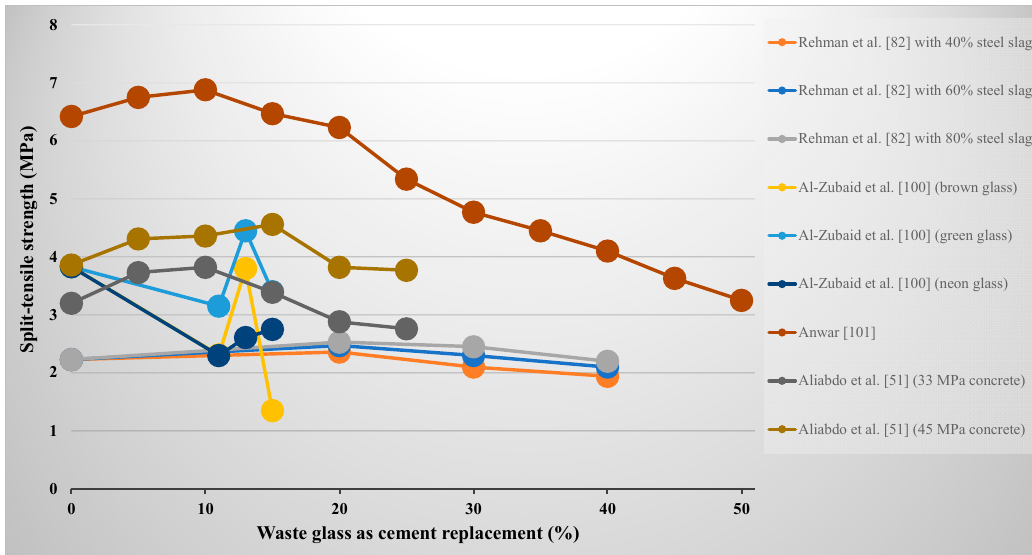
Figure 14. Effect of waste glass as cement replacement on 28-days split-tensile strength.